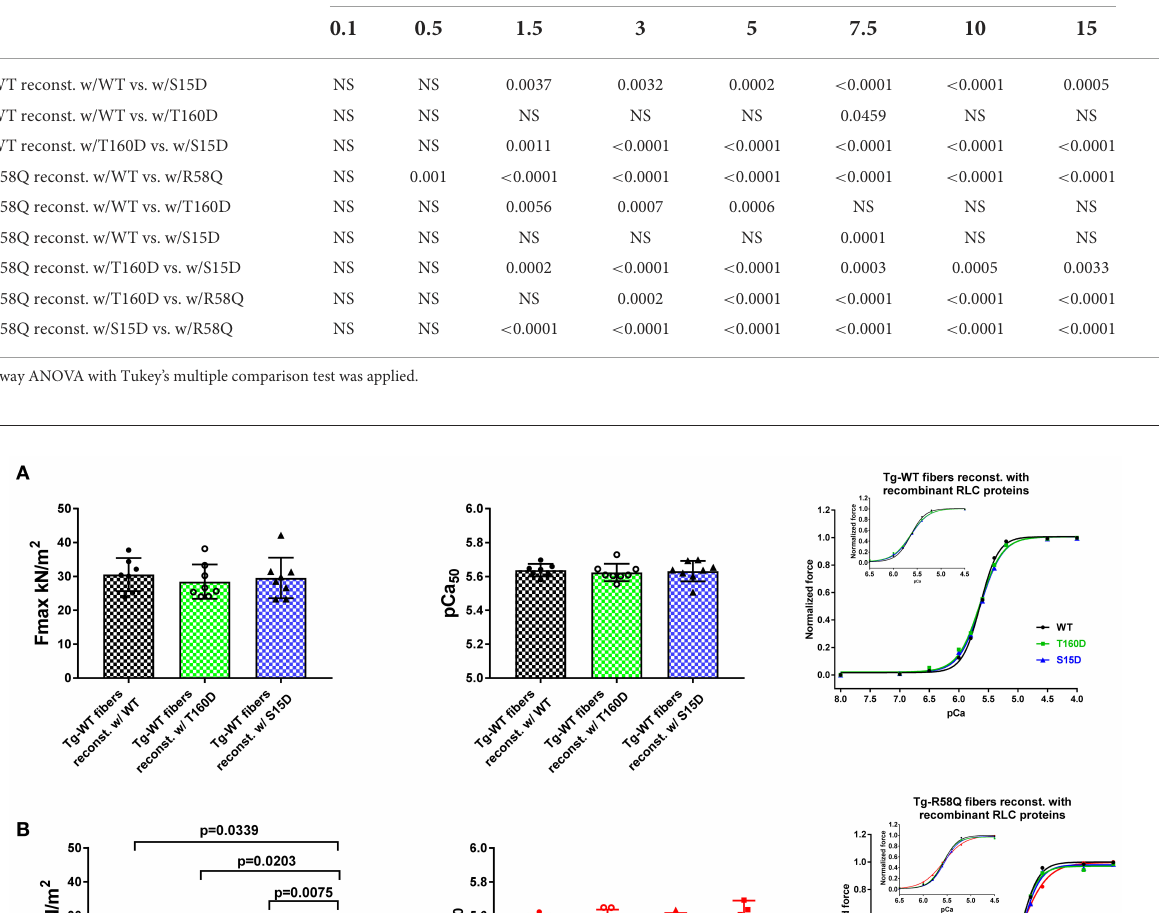
TABLE 2 Summary of statistical analysis of actin-activated myosin ATPase activity of Tg-WT and Tg-R58Q myosin reconstituted with recombinant human cardiac WT-RLC, S15D and T160D phosphomimetics, and R58Q mutant. System/actin concentration ( µ M)